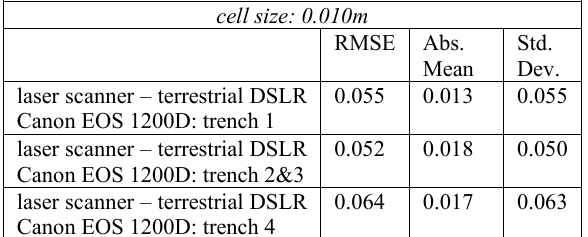
Table 7 . 3D model comparison between laser scanner and terrestrial image data of the second day of the fieldwork (19/7/2019).